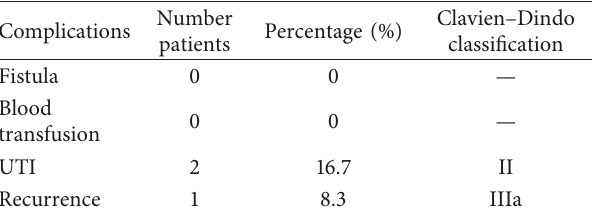
Table 2: Presentation of